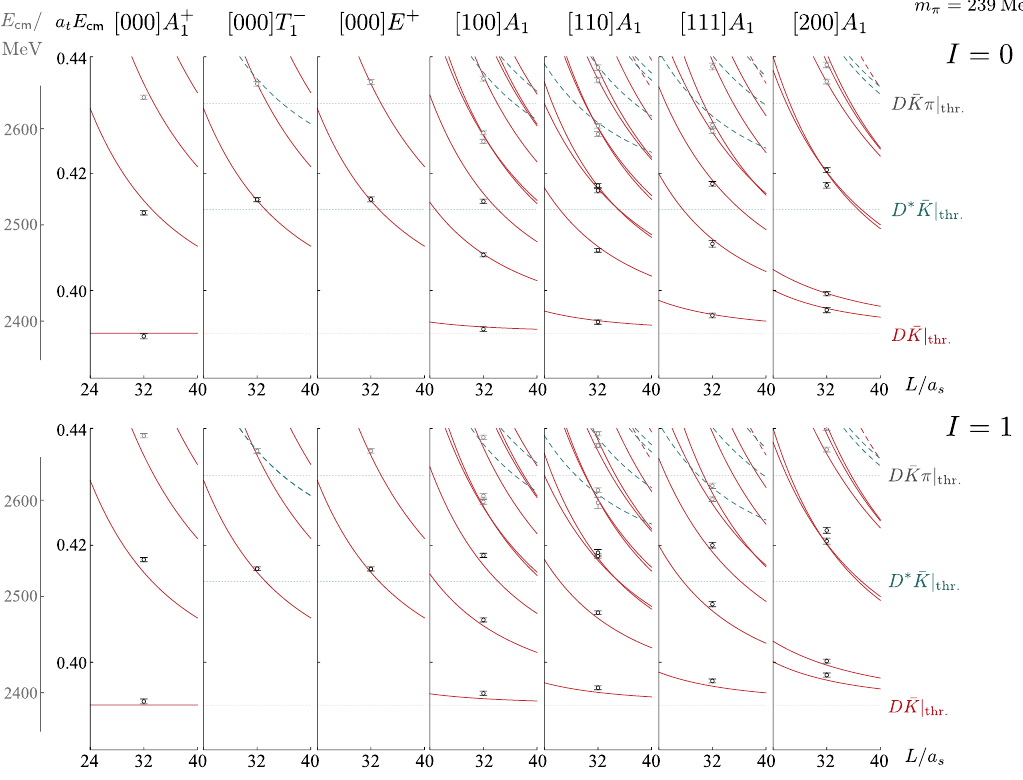
Figure 5 . As figure 3 but for I = 0 and I = 1 D ¯ K on the m π = 239 MeV